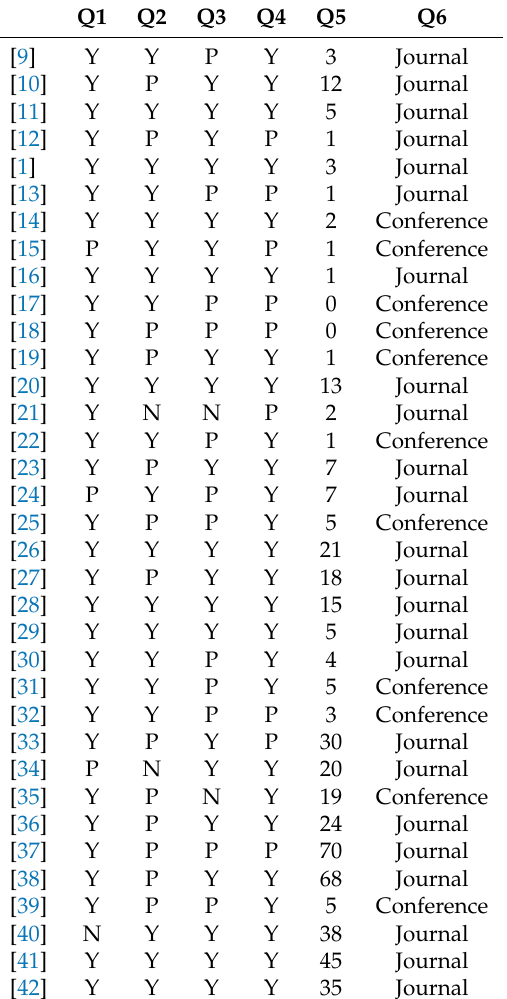
Table 11. Checklist for quality assessment for the selected